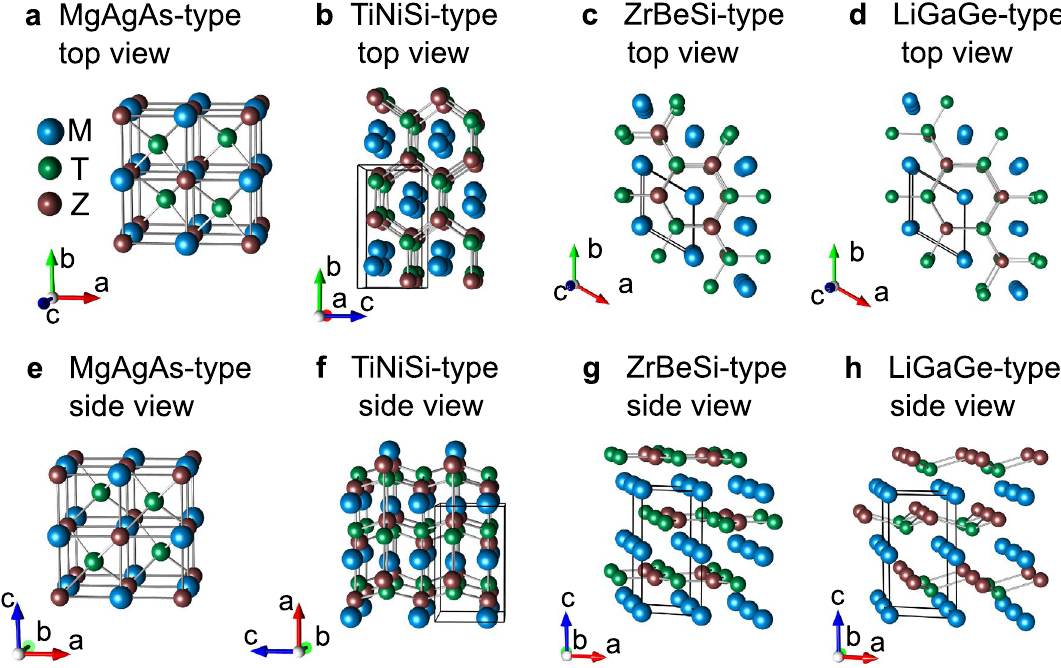
Figure 1. Different types of crystal structures attained by equiatomic ternaries with general composition MTZ , see text for details. Figure prepared in Vesta 16